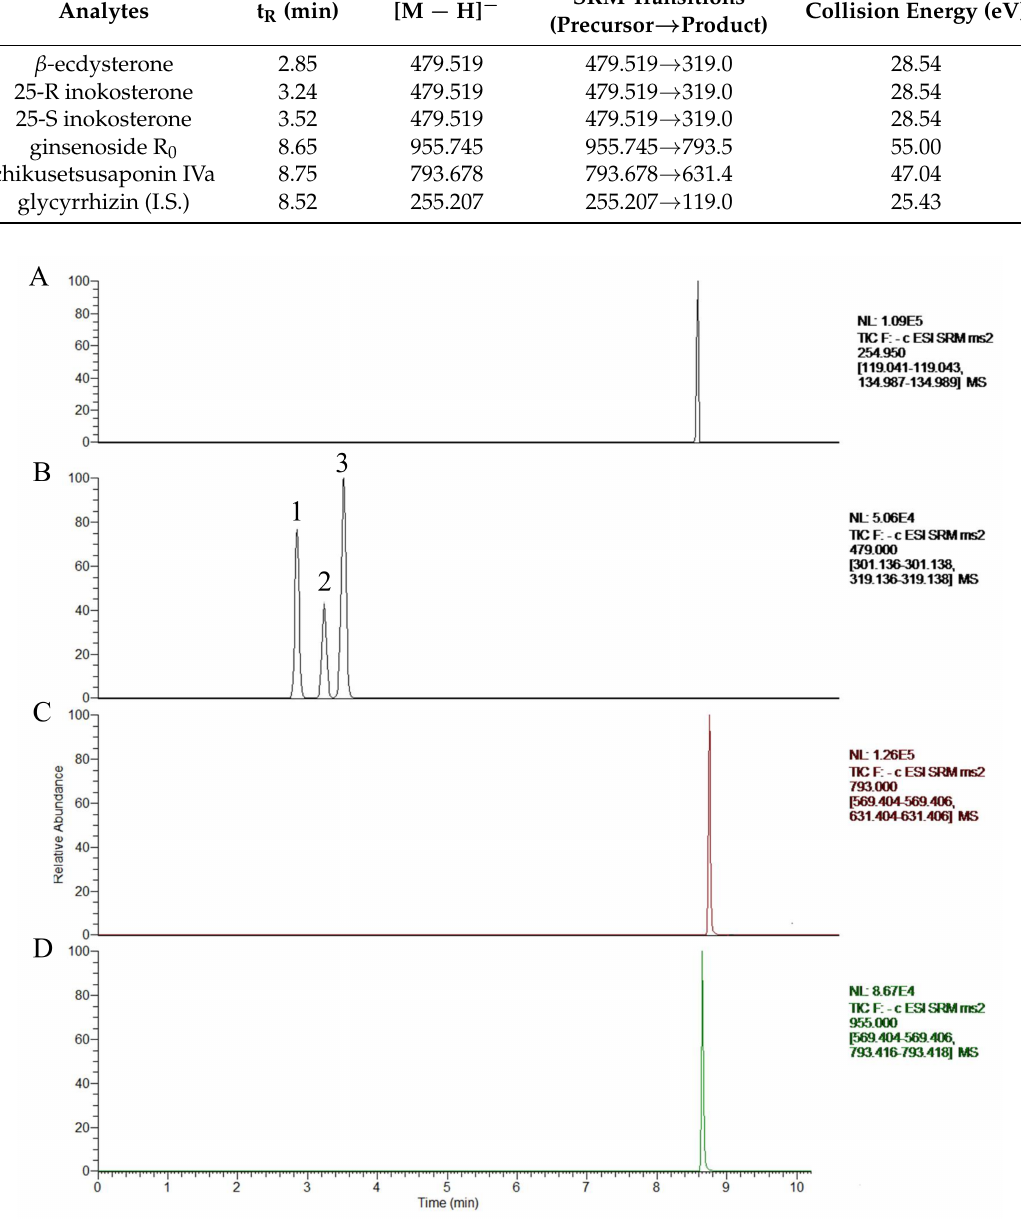
Figure 2. Total ion chromatogram with time scanning of glycyrrhizin (IS) ( A ), β -ecdysterone ( B1 ), 25-R inokosterone ( B2 ), 25-S inokosterone ( B3 ), chikusetsusaponin IVa ( C ), and ginsenoside R 0 ( D